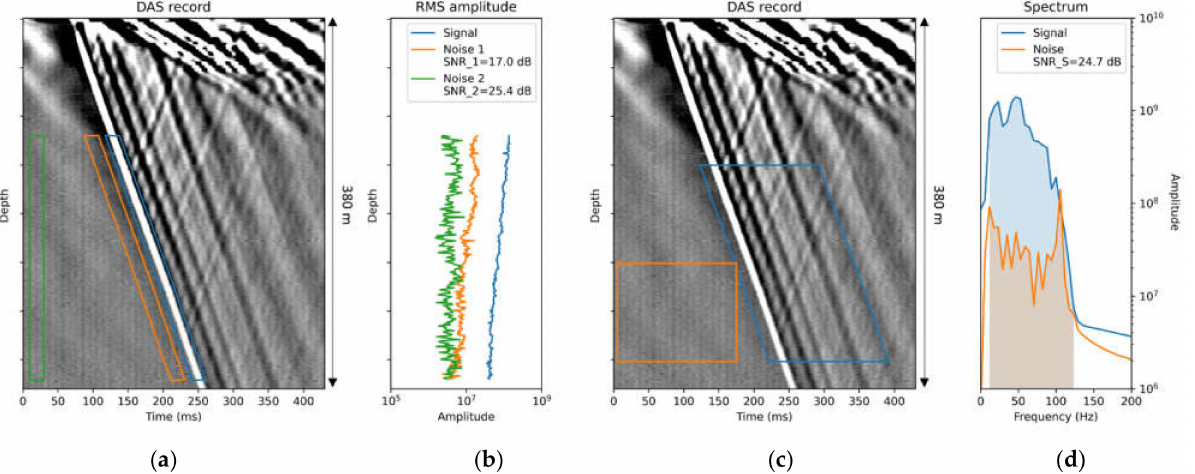
Figure 3. SNR calculation procedures. ( a ) DAS record with indicated time-domain signal (blue), noise 1 (orange), and noise 2 (green) windows for time-domain RMS calculation. ( b ) RMS amplitudes for windows shown in the previous panel. Time-domain SNR values for various noise windows (SNR_1, SNR_2) are shown. ( c ) DAS record with indicated signal (blue) and noise (orange) windows for frequency-domain RMS calculation. ( d ) Signal and noise spectra. Spectral SNR_S is